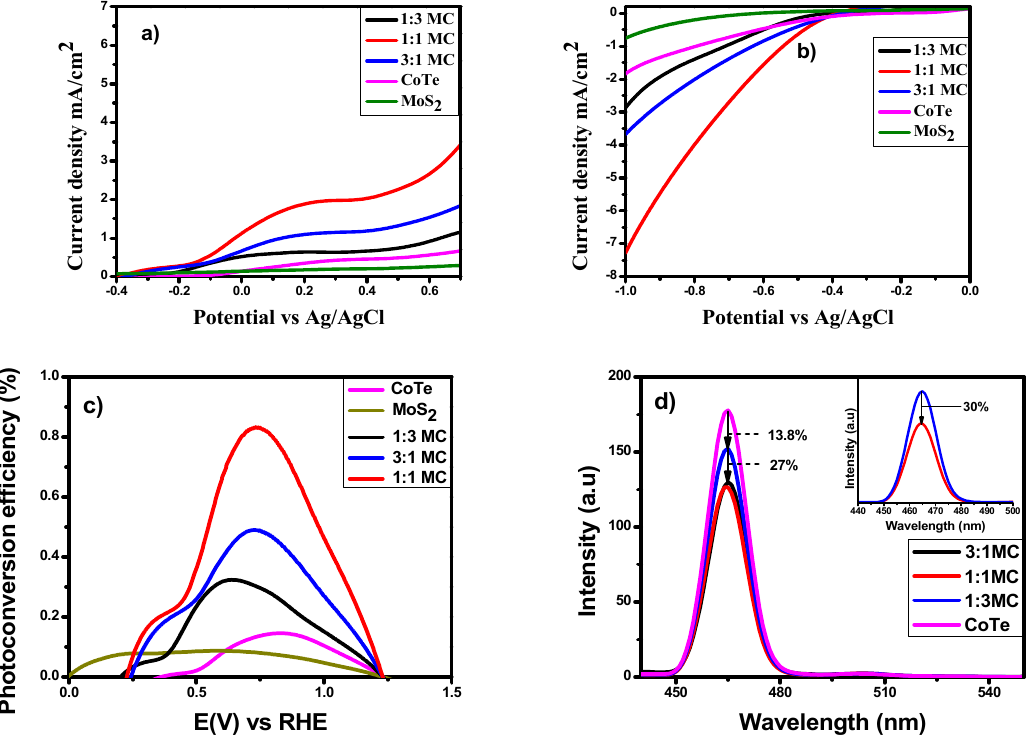
Figure 6. ( a ) I–V curves of pure MoS 2 , CoTe, 1:3 MC, 1:1 MC and 3:1 MC, for oxygen evolution. ( b ) I–V curves of pure MoS 2 , CoTe, 1:3 MC, 1:1 MC and 3:1 MC for hydrogen evolution. ( c ) Solar to hydrogen conversion efficiency of MoS 2 , CoTe, 1:3 MC, 1:1 MC and 3:1 MC. ( d ) PL spectrum of the pure CoTe, 3:1 MC 1:1 MC and 1:3 MC.